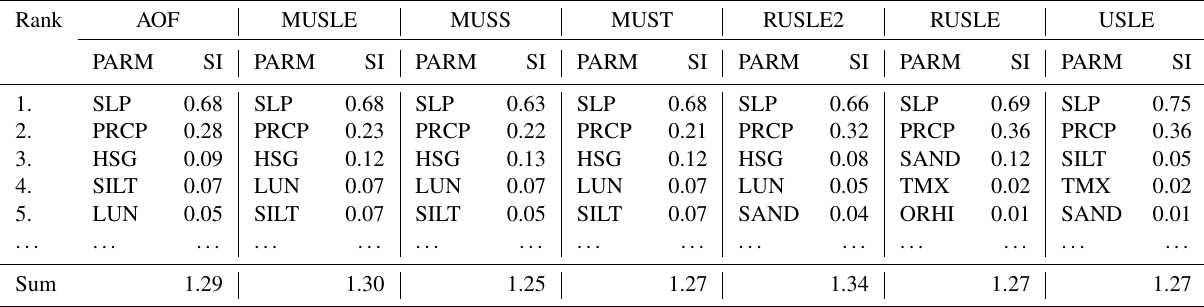
Table 5. Total-order sensitivity indices (denoted SI) ranking for the five most sensitive input parameters (PARM) for each water erosion equation including slope steepness (SLP), daily precipitation (PRCP), soil hydrologic group (HSG), land-use number (LUN), soil silt content (SILT), soil sand content (SAND), maximum air temperature (TMX) and crop residues left after harvest (ORHI). The sensitivity indices of the remaining parameters are presented in Table